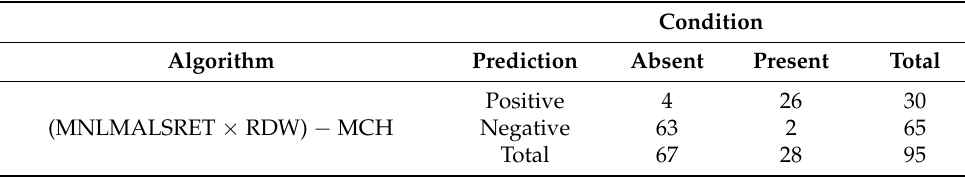
Table 4. Interlaboratory comparison of the αβ -algorithm in differentiating α -thalassemia trait and 30 β -thalassemia